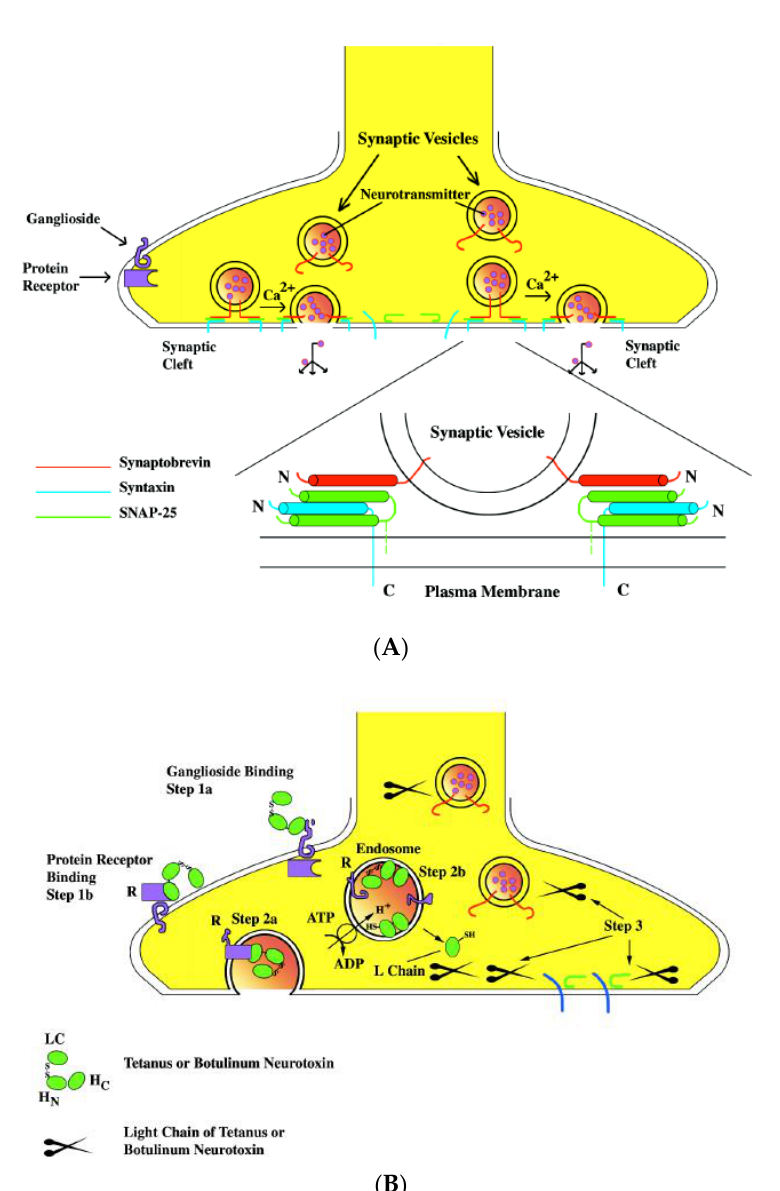
Figure 4. Schematic models of the neurotransmitter release and the actions of botulinum and tetanus toxins [108]. ( A ) Synaptic vesicles containing neurotransmitters dock with the plasma membrane through SNARE proteins (synaptobrevin, syntaxin, and SNAP-25). SNARE proteins remain in random coil conformations until associated with the SNARE complex at docking, where they form a helical bundle. ( B ) Botulinum or tetanus toxin binds to the presynaptic membrane through gangliosides and a protein receptor (step 1) internalized through endocytosis (step 2a), and its LC is translocated across the membrane (step 2b). The LC acts as a specific endopeptidase against either synaptobrevin (on synaptic vesicles), syntaxin (on the plasma membrane), or SNAP-25 (on the plasma membrane) (step 3). BoNTs (or TeNT) cleave their substrates before the SNARE complex is formed.